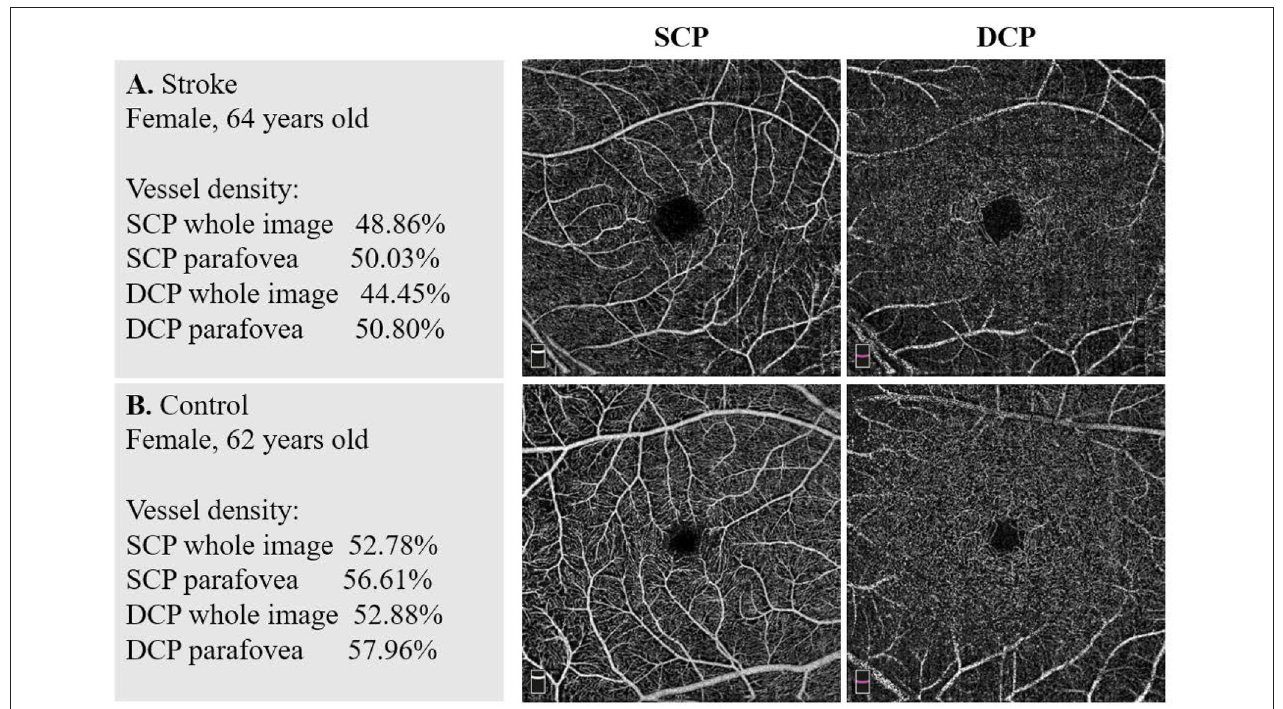
FIGURE 1 | Example images of vascular density in the two groups. (A) A stroke patient’s macular vessel density (VD) in superficial capillary plexus (SCP) and deep capillary plexus (DCP). (B) A non-stroke subject’s macular VD in SCP and DCP. There were significant differences between the stroke group and the control group in VD of both SCP and